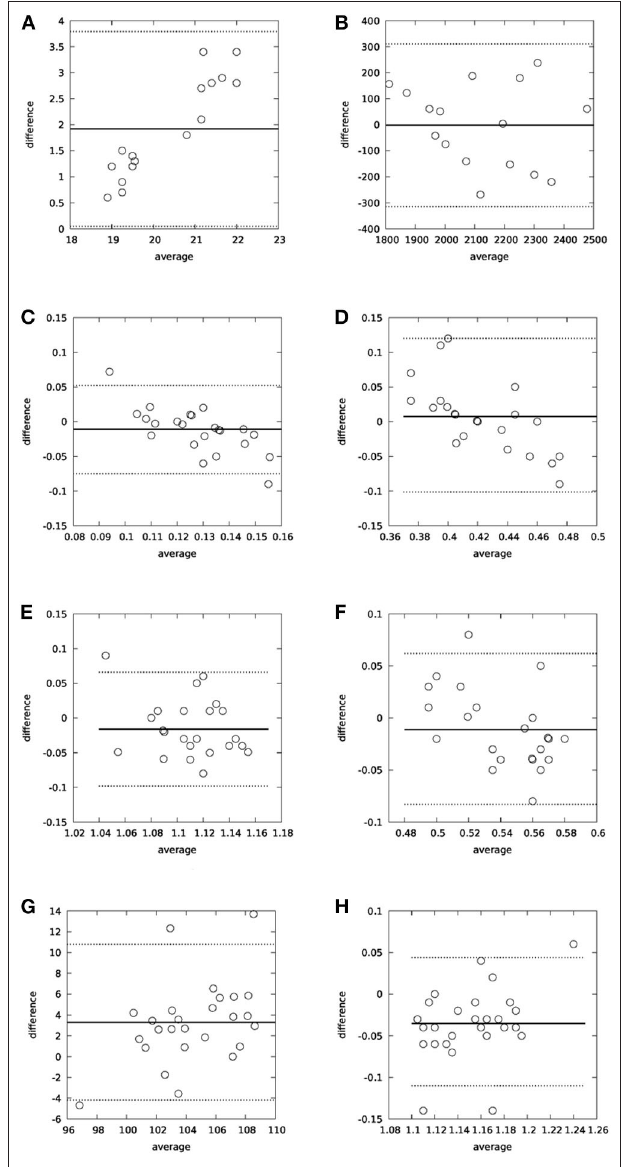
FIGURE 10 | Bland–Altman analysis for gait parameters: (A) CoPx-WinTrack © as reference, (B) Max pressure-WinTrack © as reference, (C) Double support-WinTrack © as reference, (D) Single support-WinTrack © as reference, (E) Stride time-WinTrack © as reference, (F) Step time-WinTrack © as reference, (G) Cadence-RehaGait © as reference, and (H) Stride time-RehaGait © as